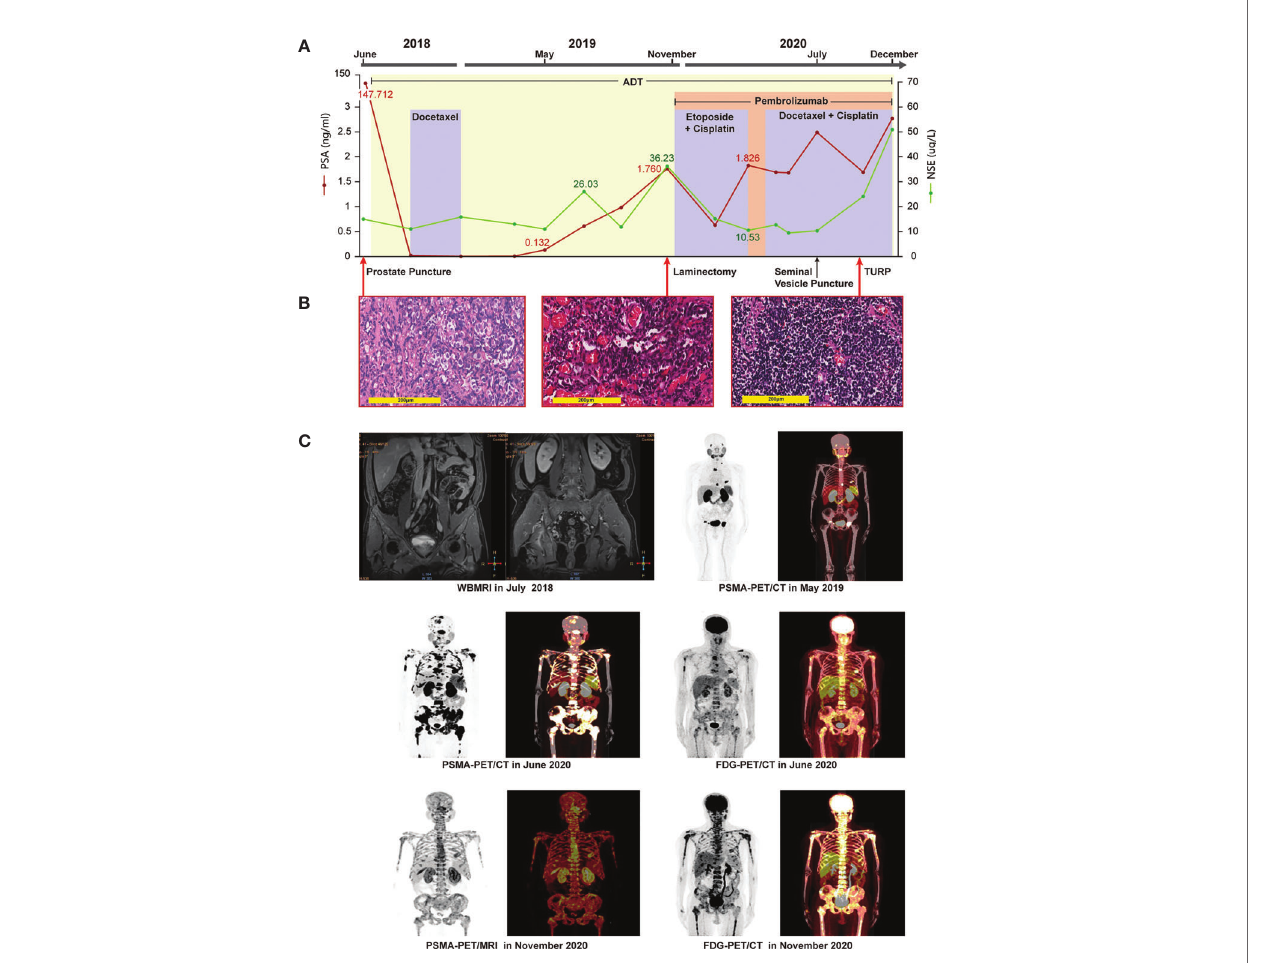
FIGURE 1 | Clinical timeline, systemic therapy, imaging data, and pathologic diagnosis. (A) systemic therapy: continuous adjusted treatment protocols in disease progression and changes in the levels of PSA and NSE during the treatment course. (B) pathologic diagnosis: (left picture) HE staining revealing prostate adenocarcinomas in the prostate puncture tissue; (middle picture) HE staining revealing metastatic prostate adenocarcinoma with neuroendocrine differentiation in the thoracic vertebral tissue; (right picture) HE staining revealing small-cell cancer in the tissue after TURP surgery. Magni fi cation: ×200. (C) Imaging data: whole- body magnetic imaging resonance showing changes in the prostate lesion before treatment in July 2018. PSMA-PET/CT showing multiple bone lesions in May 2019, after termination of docetaxel chemotherapy, and elevation of the levels of the patient ’ s PSA to 0.132 ng/mL. PSMA-PET/CT in June 2020 showing metastases in the left seminal vesicle, liver, and multiple bones. FDG-PET/CT in June 2020 showing metastases in the left seminal vesicle, liver, and multiple bones. PSMA-PET/ MRI in November 2020 showing a metastasis in the posterior wall of the bladder, diffuse bone metastases, bilateral pleural effusion liquid, and a chronic subdural hematoma in bilateral brain. FDG-PET/CT in November 2020 showing multiple metastases in the bones and liver, and bilateral pleural effusion liquid, but no abnormalities in